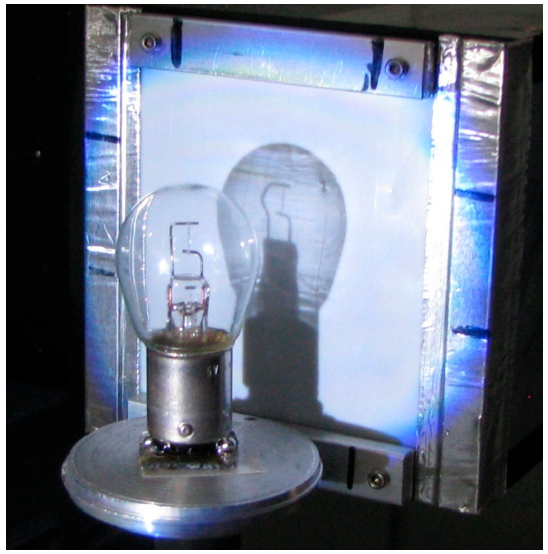
Quantum Beam Sci. 2019 , 3 , x FOR PEER REVIEW Figure 15. Optical projection of a light bulb onto a matte screen in the detector box.